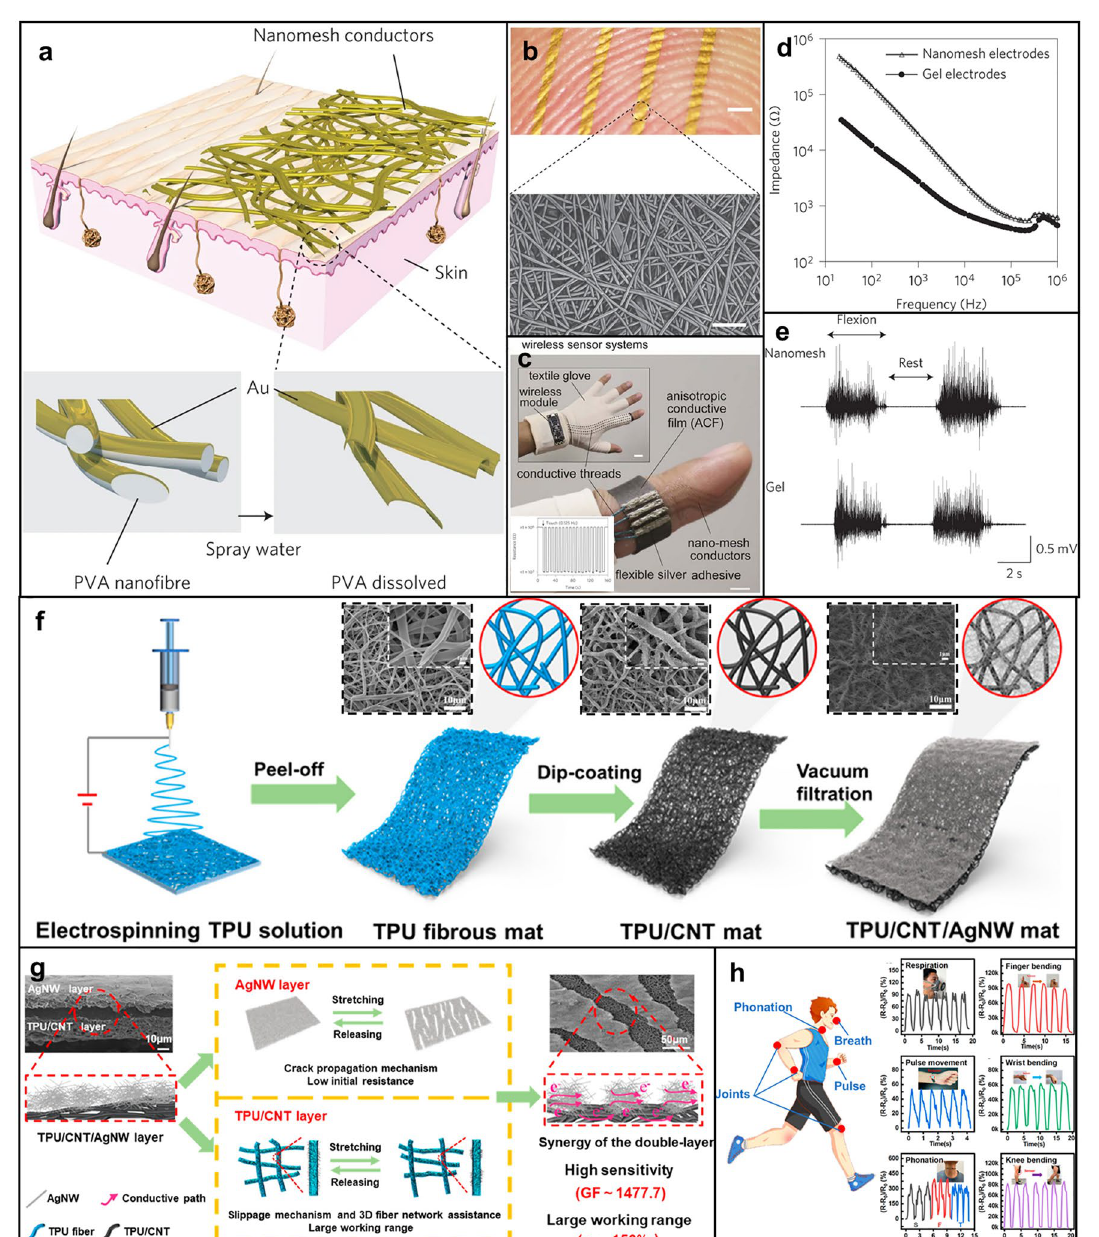
Fig. 7 Application of polymer nanomesh in soft sensors. a Preparation process of the on-skin nanomesh electronics: first, Au is evaporated onto PVA nanomesh obtained by electrospinning; then, PVA meshes are dissolved by spraying water so that nanomesh conductors can adhere to the skin. b Picture of nanomesh conductor attached to the fingertip (Scale bar represents 1 mm) and the SEM image of the nanomesh conductor after dissolving PVA nanomesh (Scale bar represents 5 µm). c On-skin wireless sensor system based on the on-skin nanomesh electronics for touch sensing (Scale bar represents 3 mm). d Measuring the impedance of the skin/electrode interface by using nanomesh electrodes compared with Ag–AgCl gel electrodes. e EMG signals were measured on the forearm, while the wrist was flexed at 90° (two times) and at rest by both nanomesh and gel electrodes. Reproduced with permission [11]. Copyright (2017), Springer Nature. f Preparation of the PU/CNT/AgNWs strain sensor, and the SEM images of PU nanomesh, PU/CNT nanomesh and PU/CNT/AgNWs nanomesh. g Design concept of the double-layered conductive network for the PU/CNT/AgNWs strain sensor. h Applications of the PU/CNT/AgNWs strain sensor for monitoring different motion signals. Reproduced with permission [204]. Copyright (2020), American Chemical